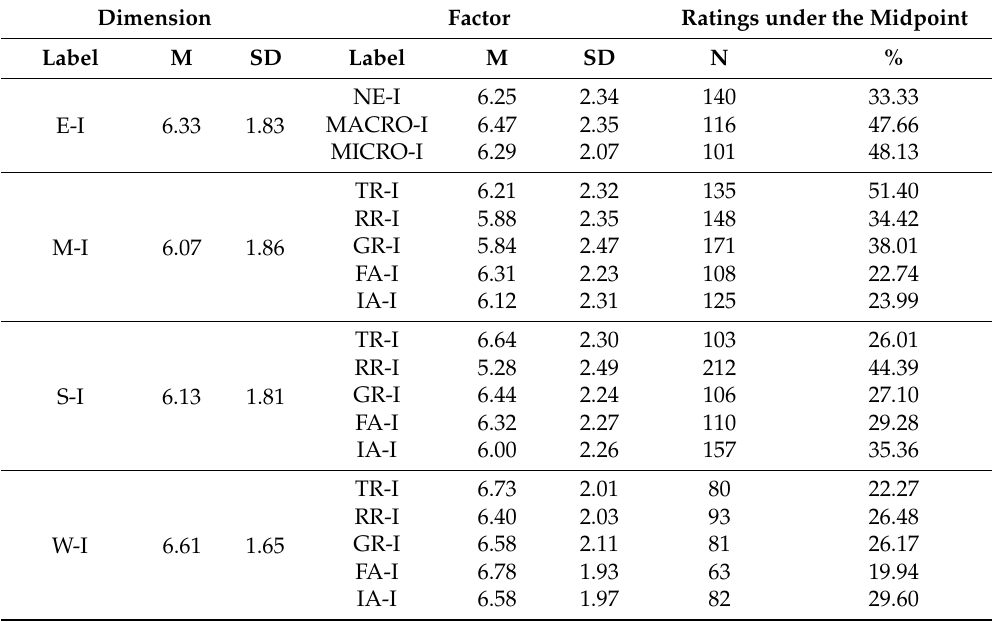
Table 1. The mean value, standard deviation (SD), and frequency and percentage of ratings under the midpoint for each dimension. Dimension